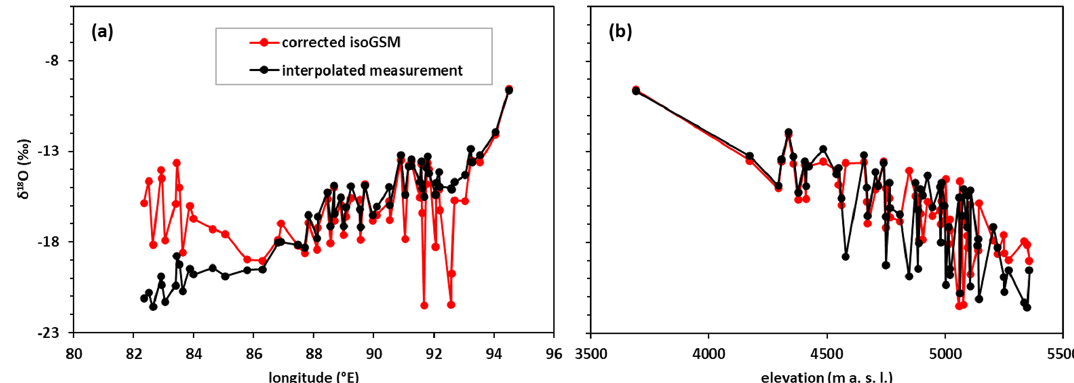
Figure 4. Comparisons of the weighted averages of precipitation δ 18 O on 63 REWs in the YTR basin by longitude (a) and elevation (b) .